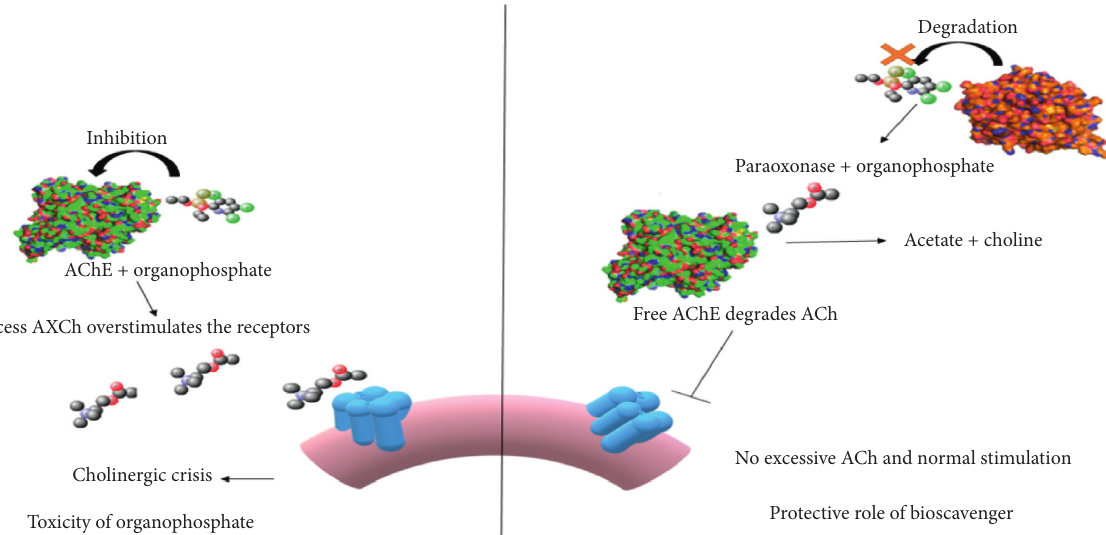
Figure 4: Diagrammatic representation of toxicity by OPCs and their detoxification. During the toxicity by OPCs, the compounds inhibit AChE and lead to excessive cholinergic effect, whereas the bioscavengers which can act as prophylactic agents neutralize the OPCs before they reach their targets and result in normal physiological hydrolysis of ACh and thus control proper signalling